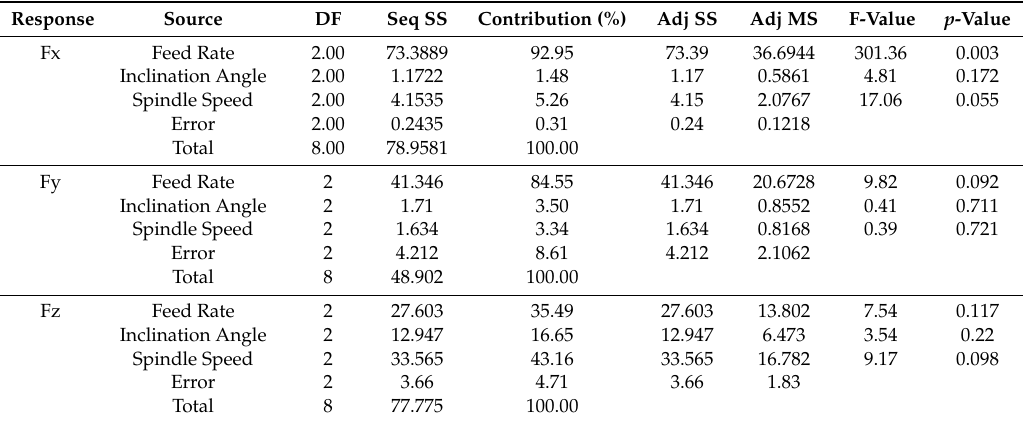
Table 6. Results of the ANOVA for Cutting force.